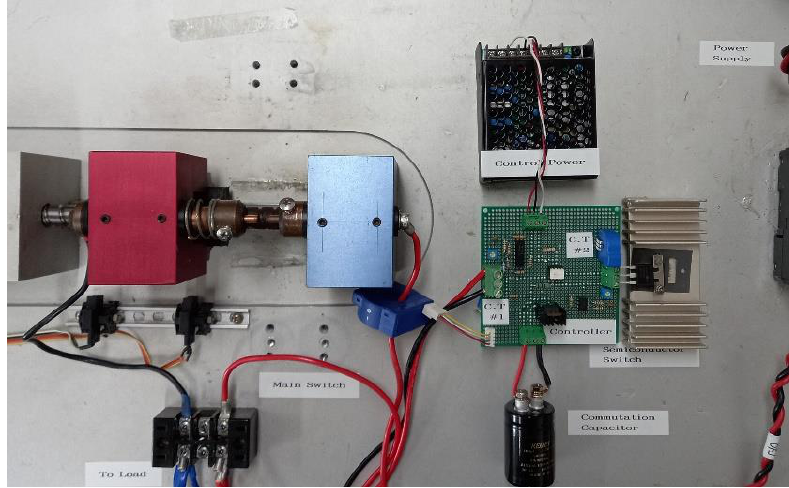
Figure 5. Photograph of experimental setup for the proposed MVDC hybrid circuit breaker.